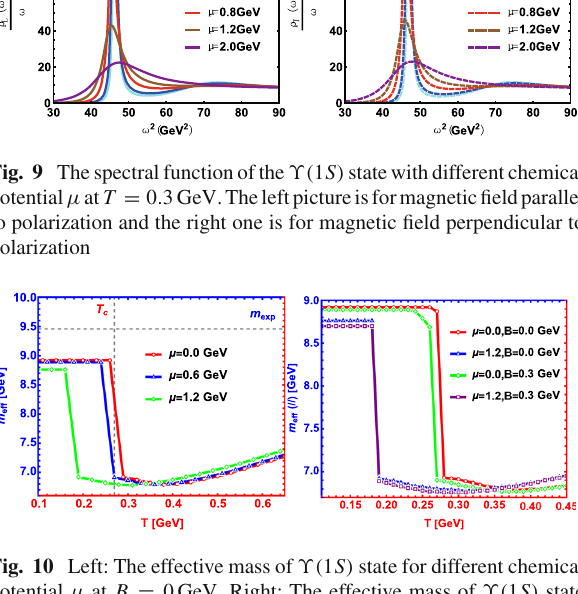
field and the mutation occurs in a smaller temperature with the increasing magnetic field in our model. The reason for this mutation is that the confinement-deconfinement